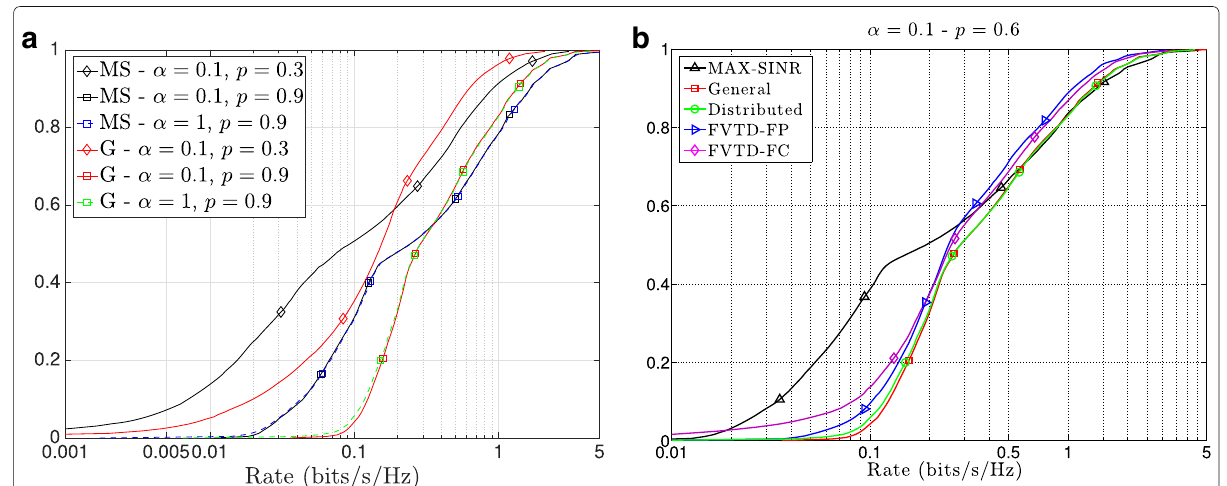
Fig. 5 CDF of the instantaneous user rates for different user association strategies. a CDF of the user rates for different energy harvesting intensities ( p = 0.3; p = 0.6; and p = 0.9) and the value of α for the proposed strategy and the max-SINR strategy. b CDF of the user rates for the different proposed strategies and the max-SINR